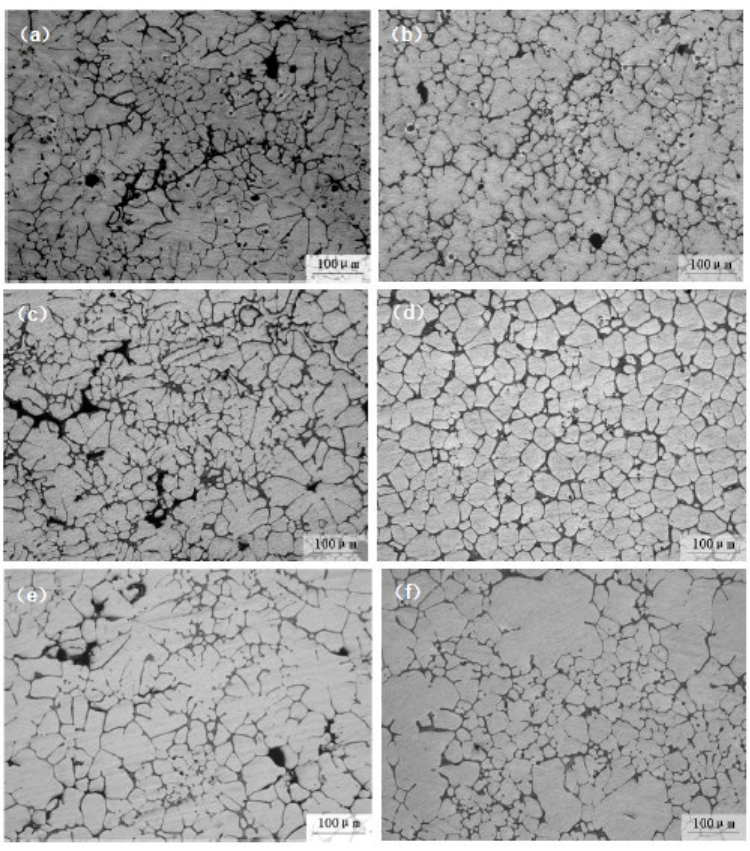
Figure 8. Microstructures of the Mg-3.03Ca alloy treated with different ultrasonic treating tempera- tures. ( a , c , e ) without ultrasonic; ( b , d , f ) ultrasonic treatment ( a , b ) 730 °C; ( c , d ) 700 °C; ( e , f ) 670 °C.